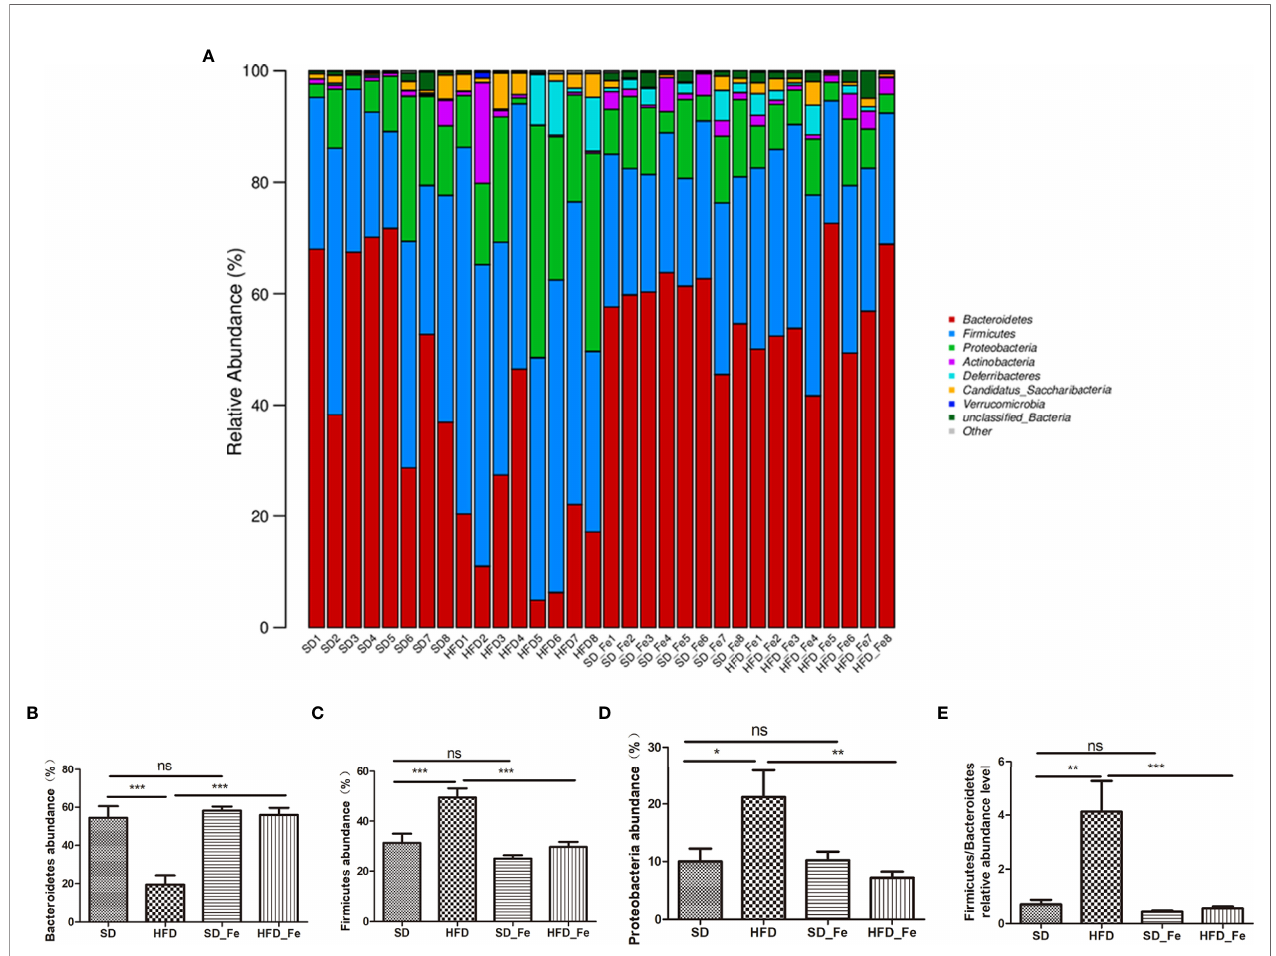
FIGURE 6 | Effects of feno fi brate on the relative abundance of gut microbiota in high-fat diet (HFD) mice at the phylum level. (A) The relative abundance of gut microbiota at the phylum level. (B – H) The relative abundance of Bacteroidetes (B) , Firmicutes (C) , Proteobacteria (D) and Firmicutes/Bacteroidetes (E) . SD group, standard diet group; HFD group, high-fat diet group; SD_ Fe group, standard diet plus feno fi brate group; HFD_ Fe group, high-fat diet plus feno fi brate group. n = 8; ns, not signi fi cant; *P < 0.05; **P < 0.01; ***P < 0.01. Bar graphs represent mean values ±